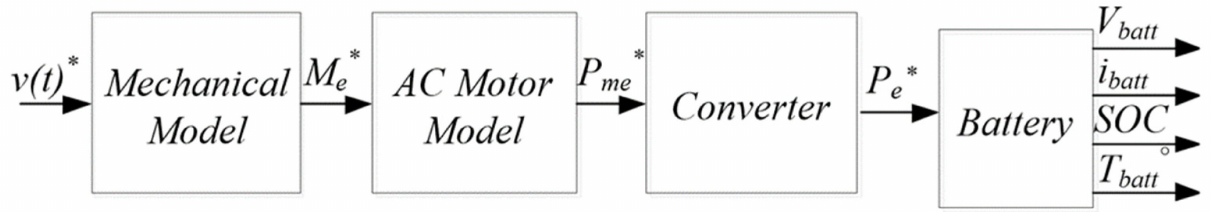
Figure 2. The dynamic model of an Electric Vehicle for the estimation power delivery by, or supplied to, the battery pack